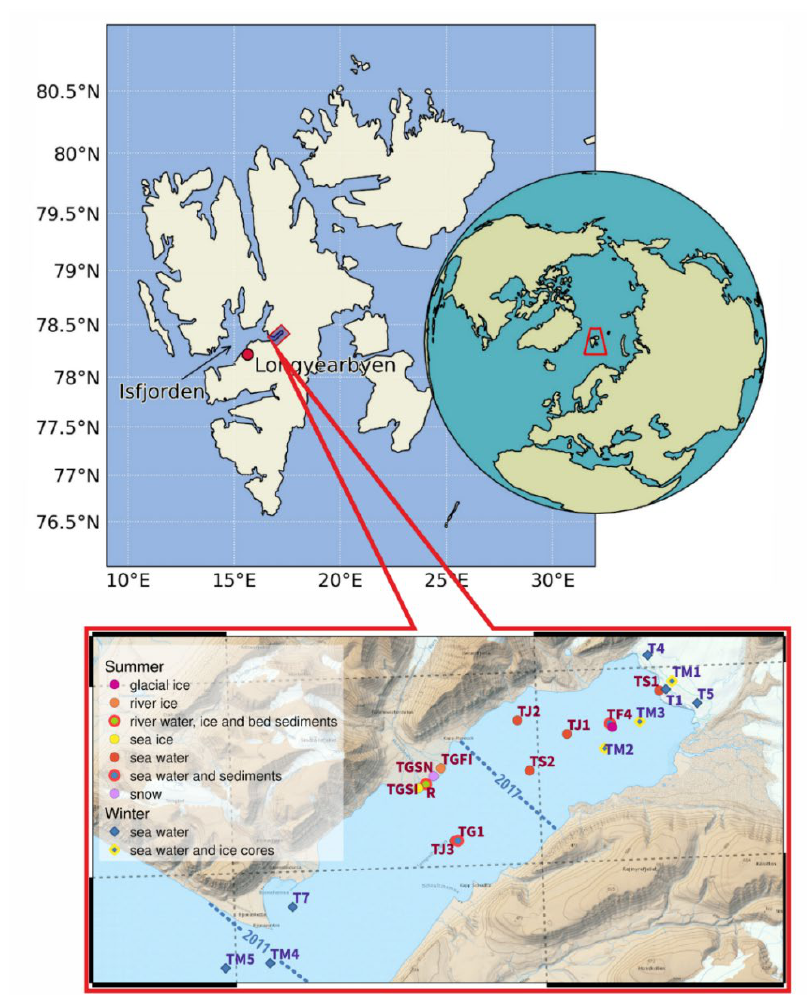
Figure 1. Positions of the stations sampled in the expeditions in February 2011 (T1, T4, T5, T7), September 2011 (TS1, TS2), March 2014 (TM1, TM2, TM3, TM4, TM5), June 2015 (TJ1, TJ2, TJ3), and June 2017 (TG1). The stations in the fjord mouth (TM4 and TM5) were taken in the winter from a boat when it was impossible to sample in the central part of the fjord due to ice conditions. The dotted lines indicate the winter positions of the solid ice boundaries in 2017 and 2011.